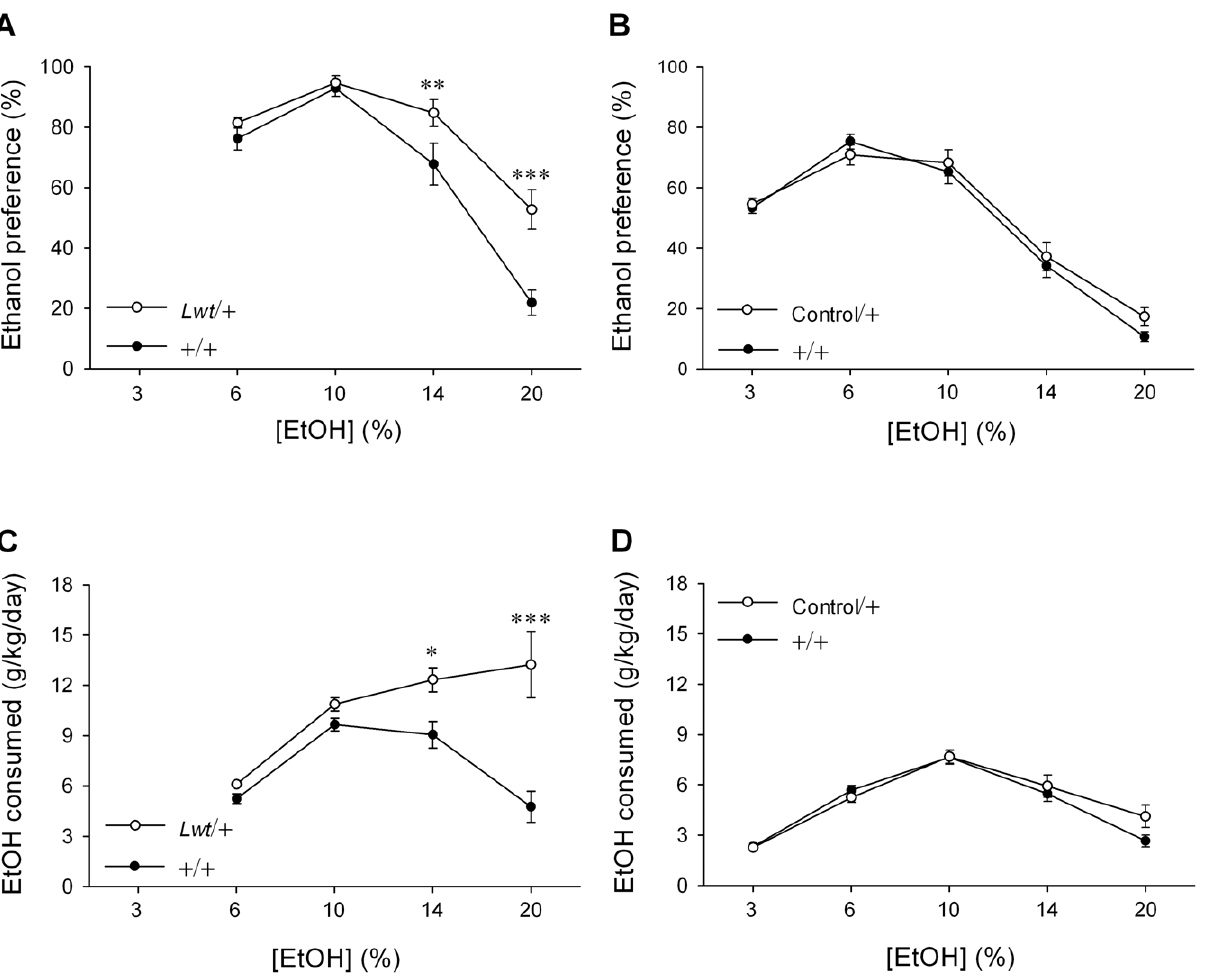
Figure 7. Lwt / + congenic mice exhibit a higher preference for and consumption of ethanol. (A) Lwt / + (n=13) animals have a higher preference for ethanol than + / + littermates (n=14). (B) There was no difference in ethanol preference in Control/ + (n=15) relative to + / + (n=15) littermates. (C) Lwt / + (n=13) animals consume more ethanol than + / + littermates (n=14). (D) There was no difference in ethanol consumption in Control/ + (n=15) relative to + / + (n=15) littermates. (* P , 0.05; ** P , 0.01; *** P , 0.001, post hoc Tukey